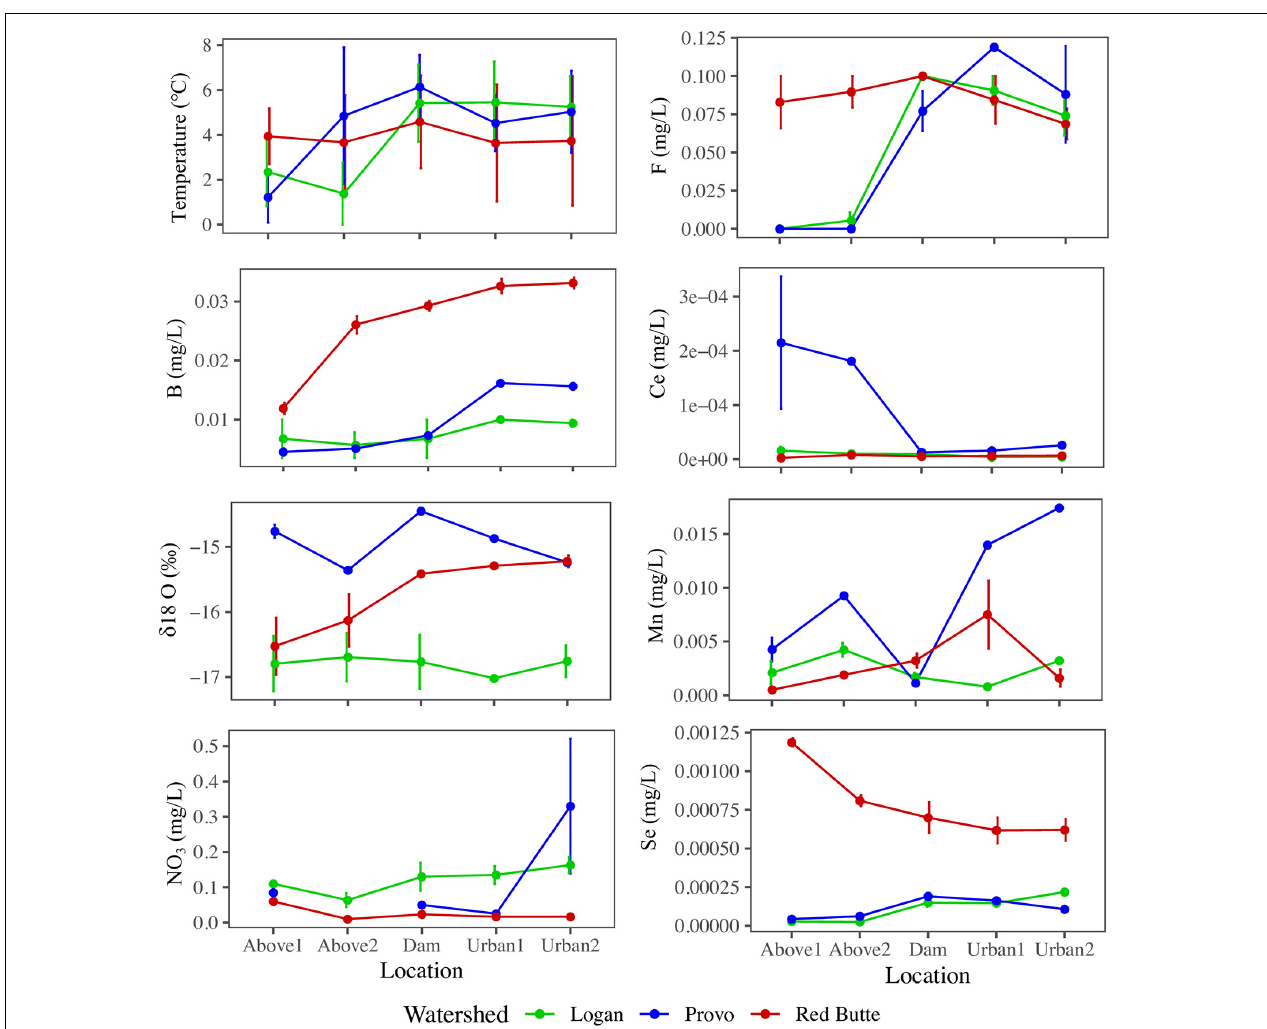
FIGURE 4 | Longitudinal profiles of stream physiochemical variables selected by backward stepwise RDA ordination of bacterial communities in streams in three Utah watersheds (Red Butte Creek, Provo River, and Logan River) across three seasons (Fall, Winter, and Spring). Location indicates position relative to reservoirs and urban centers. Means and standard errors, where determinable, are shown (some data points were removed for QA/QC